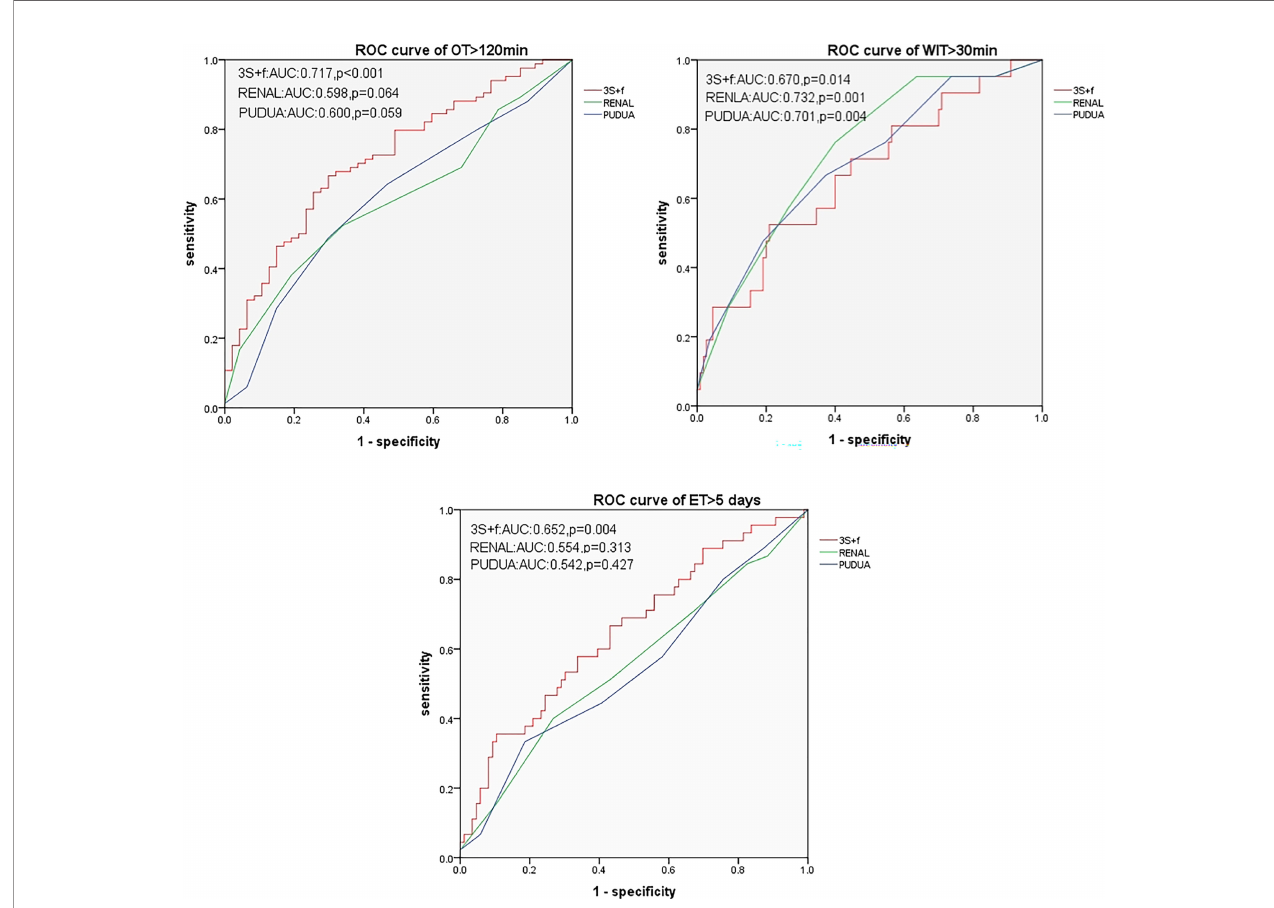
FIGURE 2 | ROC curves for predicting OT > 120 min, WIT > 30 min, and ET > 5 days. OT, operative time; WIT, warm ischemia time; ET, extubation